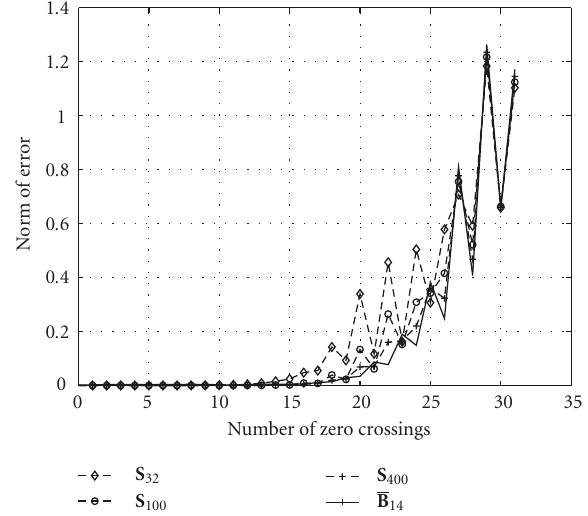
Figure 4: Comparison of error norms between the discrete Hermite-Gaussian like eigenvectors and the samples of the Hermite-Gaussian functions of B 14 and S 32 , S 100 , and S 400 methods for N = 32.